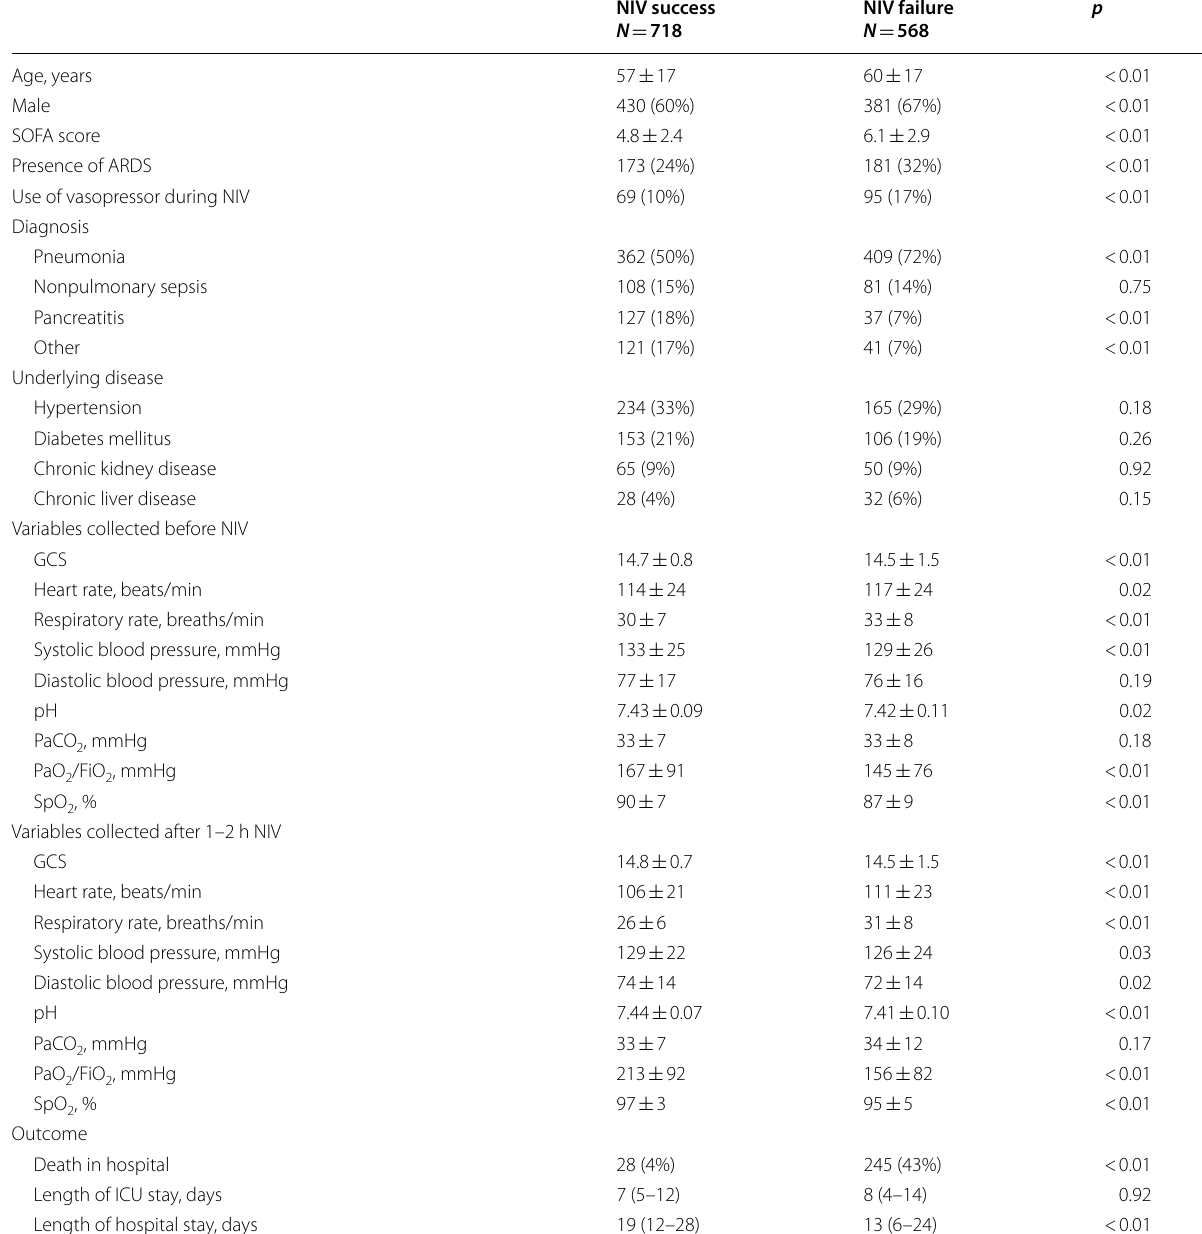
Table 1 Comparisons between patients with NIV success and